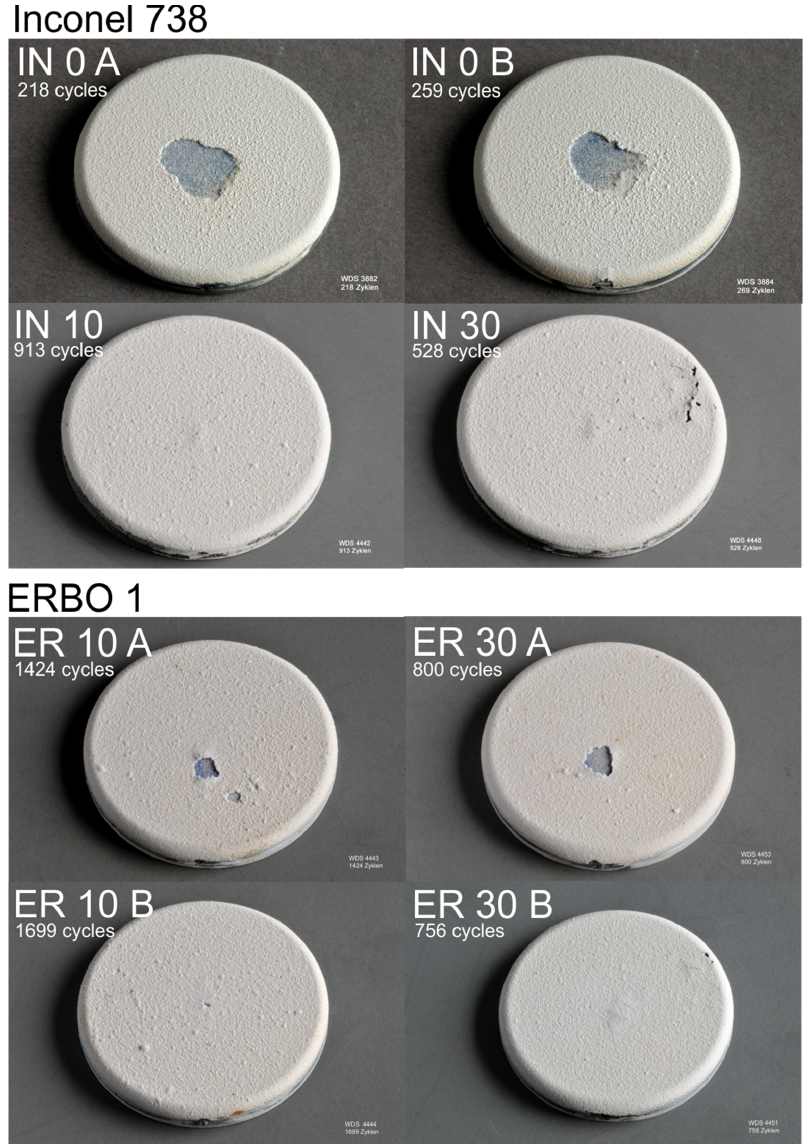
Figure 2. Top view of thermally cycled TBCs with yttria-stabilized zirconia SPS top coat after testing in the burner-rig facility for different substrate materials, ODS bond coats with (10% alumina) and (30% alumina) and conventional bond coats (0% alumina), A and B indicating two samples cycled under the same conditions. Sample specifications, see Table A1.